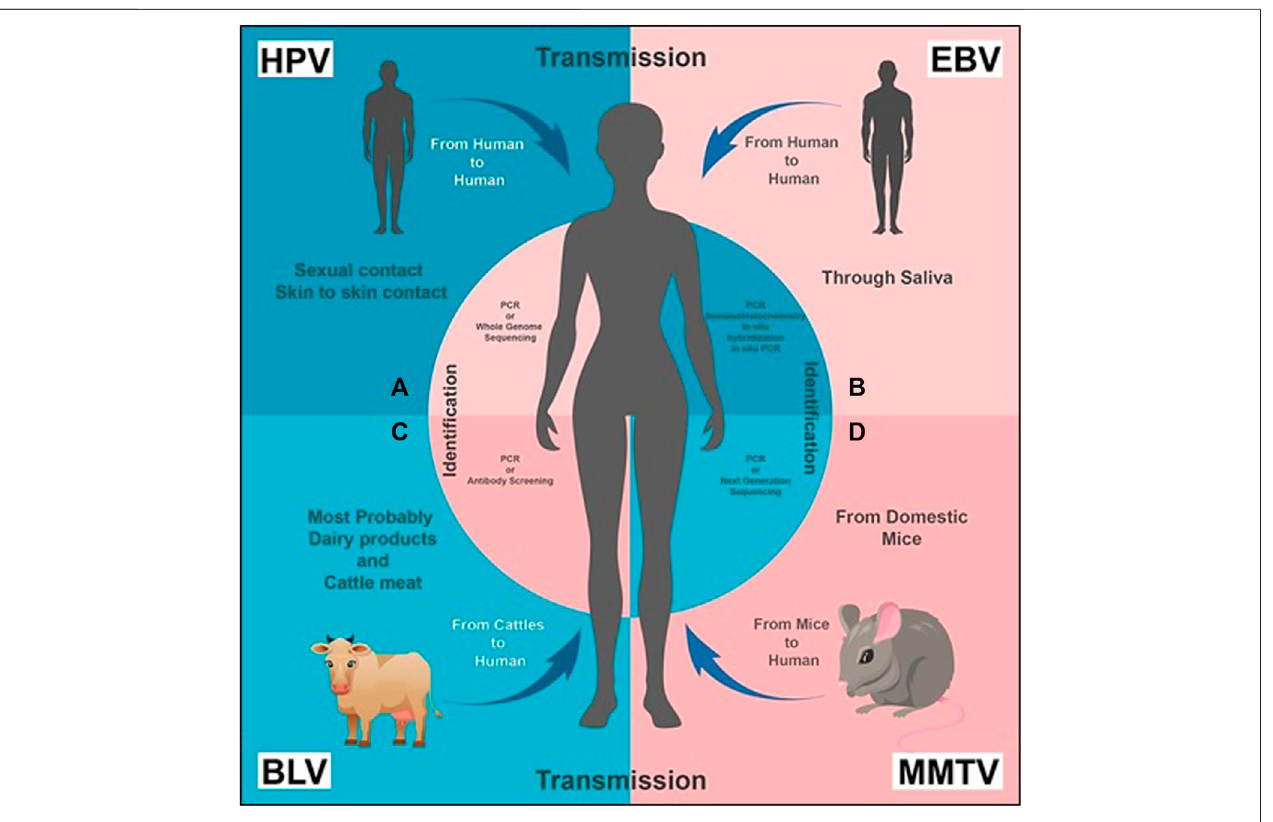
FIGURE1| TransmissionandIdenti fi cation ofthe viruses,respectively: (A) HPVtransmissiontakesplace fromhuman tohumanthrough sexual and/or skintoskin contact. It can be diagnosed by PCR (recommended) or Whole Genome Sequencing. (B) EBV is transmitted through saliva from human to human. Its presence can be identi fi edbyPCR,immunohistochemistry, insitu hybridizationand insitu PCR. (C) BLVtransmissionprimarilytakesplacefrombovineorcattle(usuallydomesticanimals) to humans; dairy and cattle meat can also be a source of transmission. PCR or antibody screening of a human blood sample is carried out for its diagnosis. (D) MMTV is transmitted from mice to human. Its presence is identi fi ed by PCR or